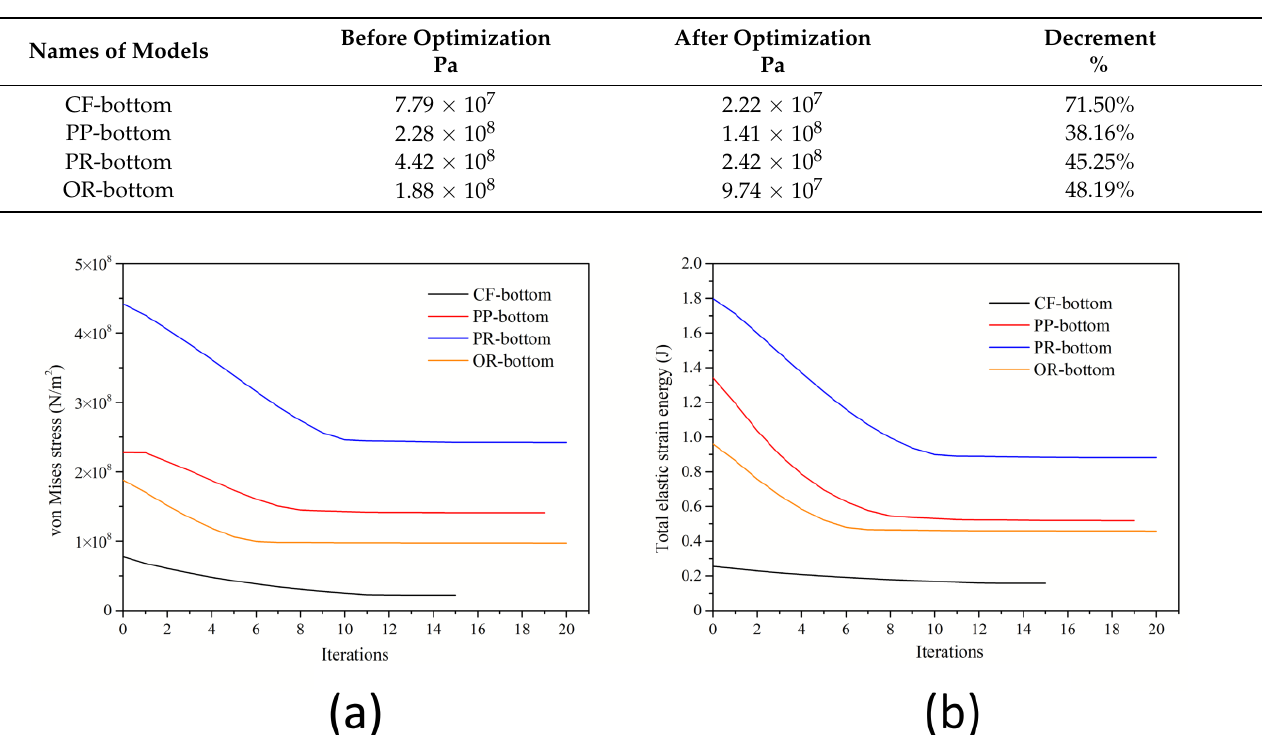
Table 4. Comparison of the overall maximum stress of the models.